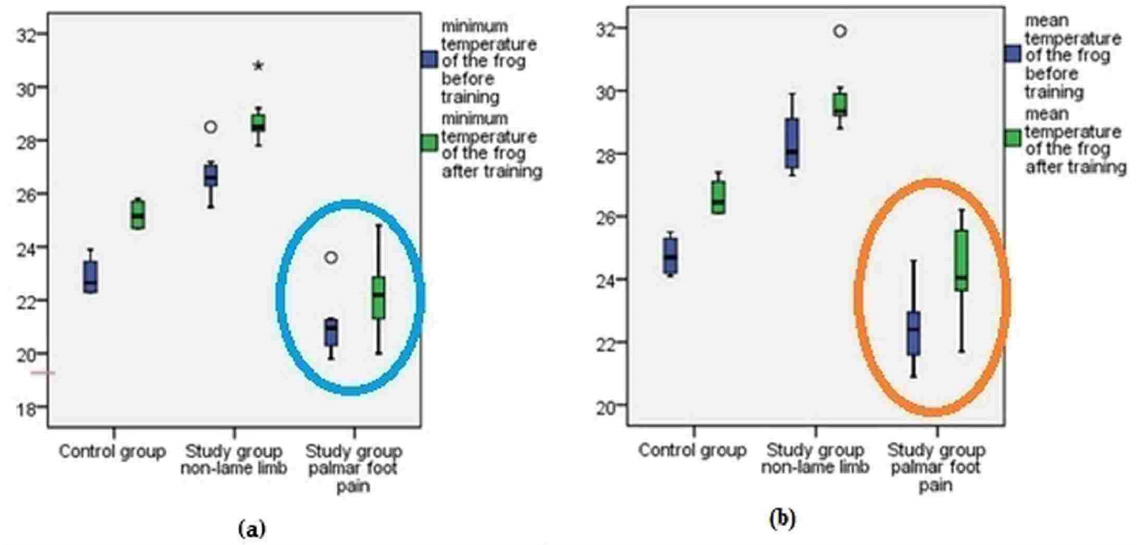
Figure 6. ( a ) Boxplot diagram showing the minimum temperature values of the frog area before and after training. Low values for minimum temperature before and after training are observed for the study group with palmar foot pain (blue circle). ( b ) Boxplot diagram showing the mean temperature values of the frog area before and after training. Low values for mean temperature before and after training for the study group with palmar foot pain are observed (orange circle); *—extreme outliers temperature, ᵒ —mild outliers temperature